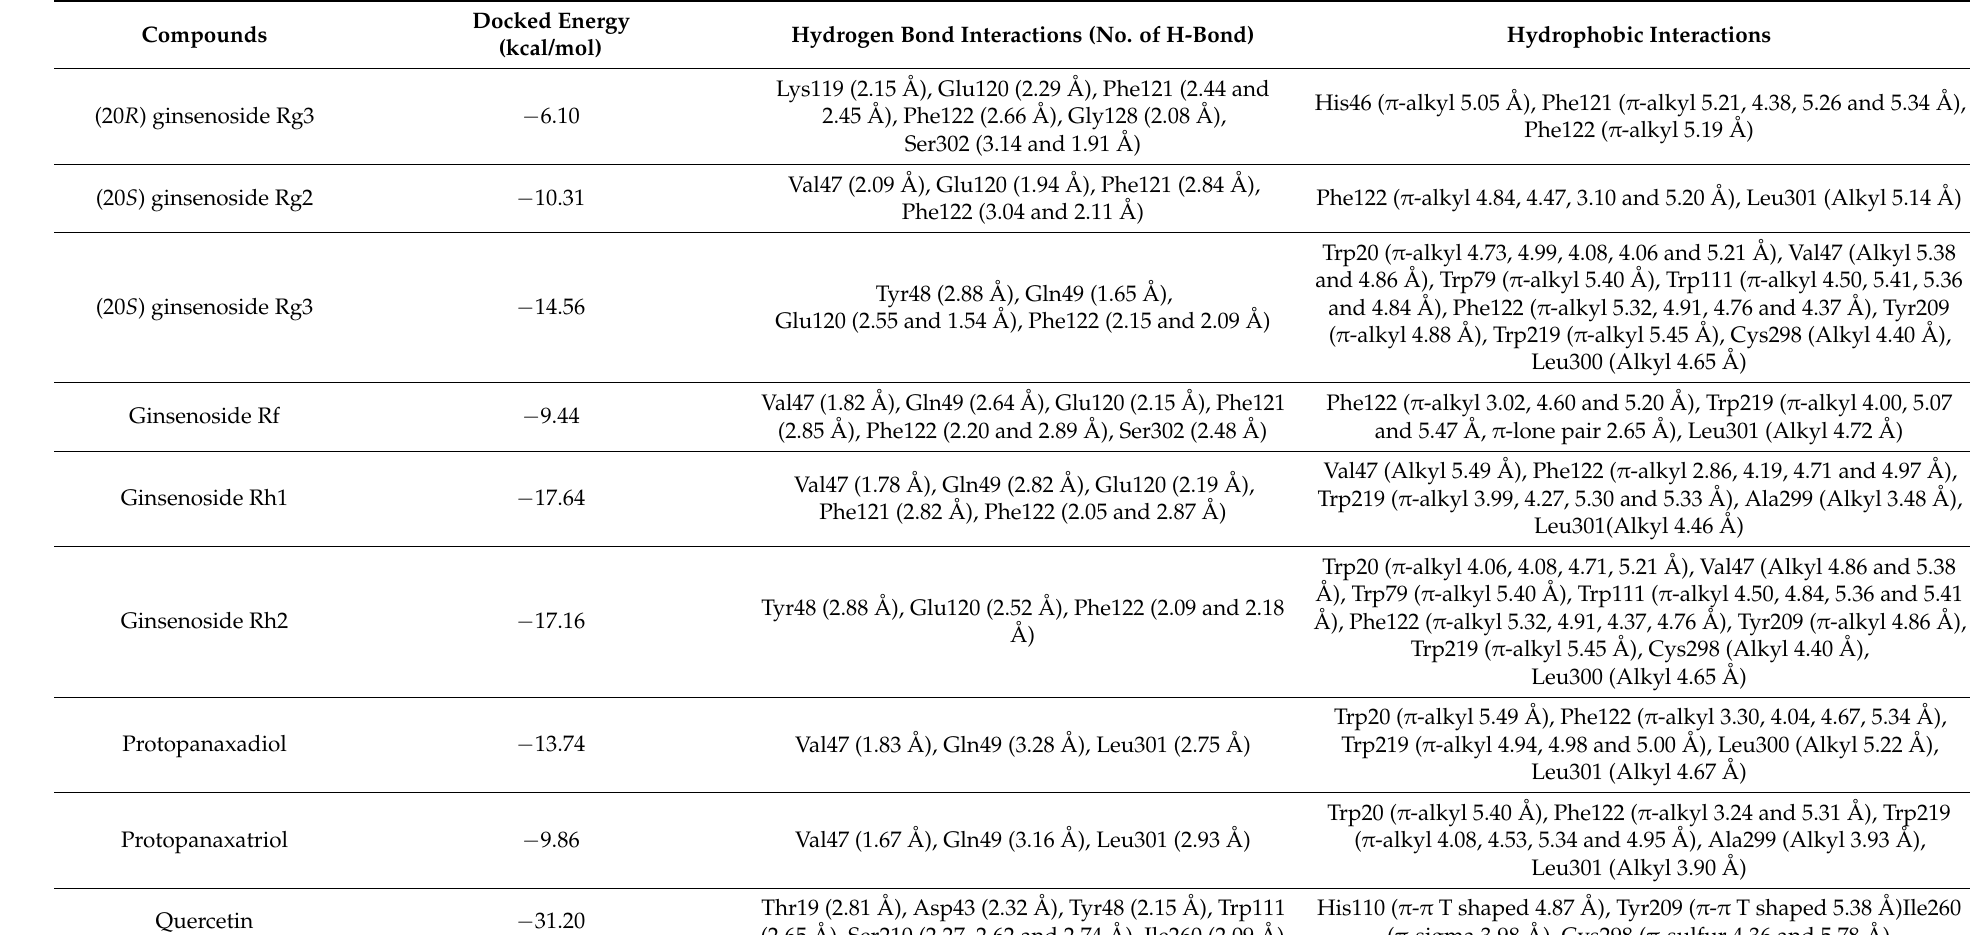
Table 2. Binding energies and binding interactions of ginsenosides with RLAR using the LeadIT docking program (FlexX) and visualization by Discovery Studio